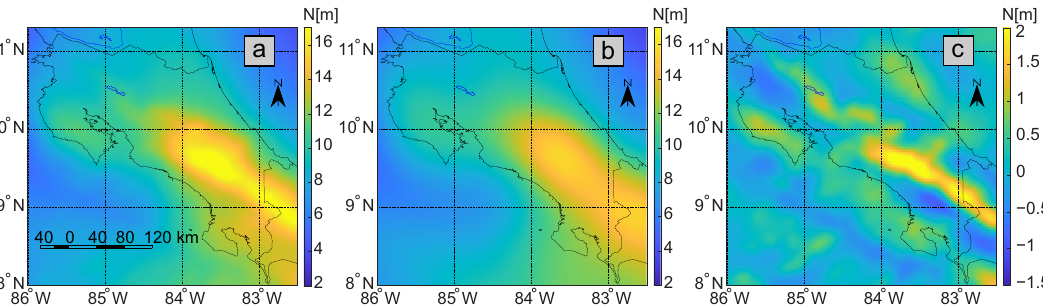
Figure 6. Comparison of gridded geoid undulations (N) for the study area: ( a ) EGM2008. ( b ) EMG96. ( c ) Difference between EGM2008 and EGM96: the mean/min/max difference is 0.2/ − 0.9/2.3 m; the Standard Deviation (STD) is